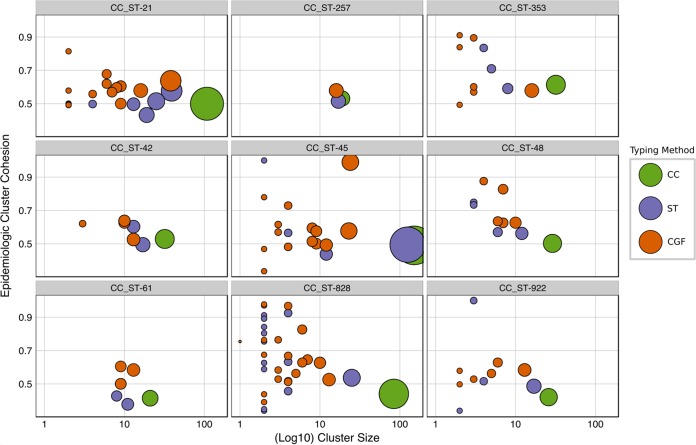
Comparison of ECC values for clusters generated via MLST CCs, MLST STs, and CGF for the isolates used in this study (n = 654). Individual facets of the plot contain the isolates from each of nine dominant MLST clonal complexes in the data set (indicated at the top of each box). Green circles denote “parent clusters” based on CCs; membership in subclusters is also shown. The relative membership size of each cluster is indicated by the radius of each circle on the plot and given by the values on the x axis. The average ECC of each cluster is given by its position along the y axis. Subclusters containing only one member, which were excluded from the ECC analysis, were excluded from the figure (ST, n = 101; CGF, n = 62). The plot was generated in R using the ggplot2 package.